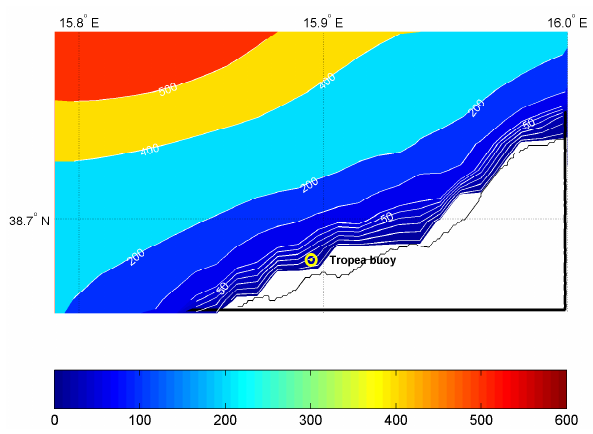
comparison of SWAN vs. buoy Dir. (d) WAM series of wind sea, swell and total H s out of the regional grid.